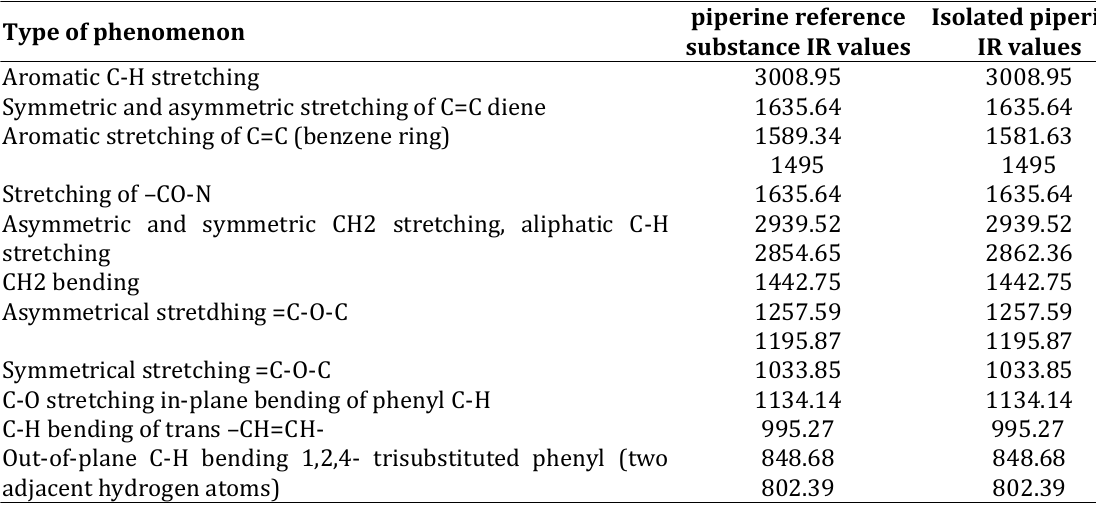
Figure 5. FTIR spectra of isolated piperine (A) and piperine reference substance (B) Table I. The comparison of IR spectra of isolated piperine and piperine reference